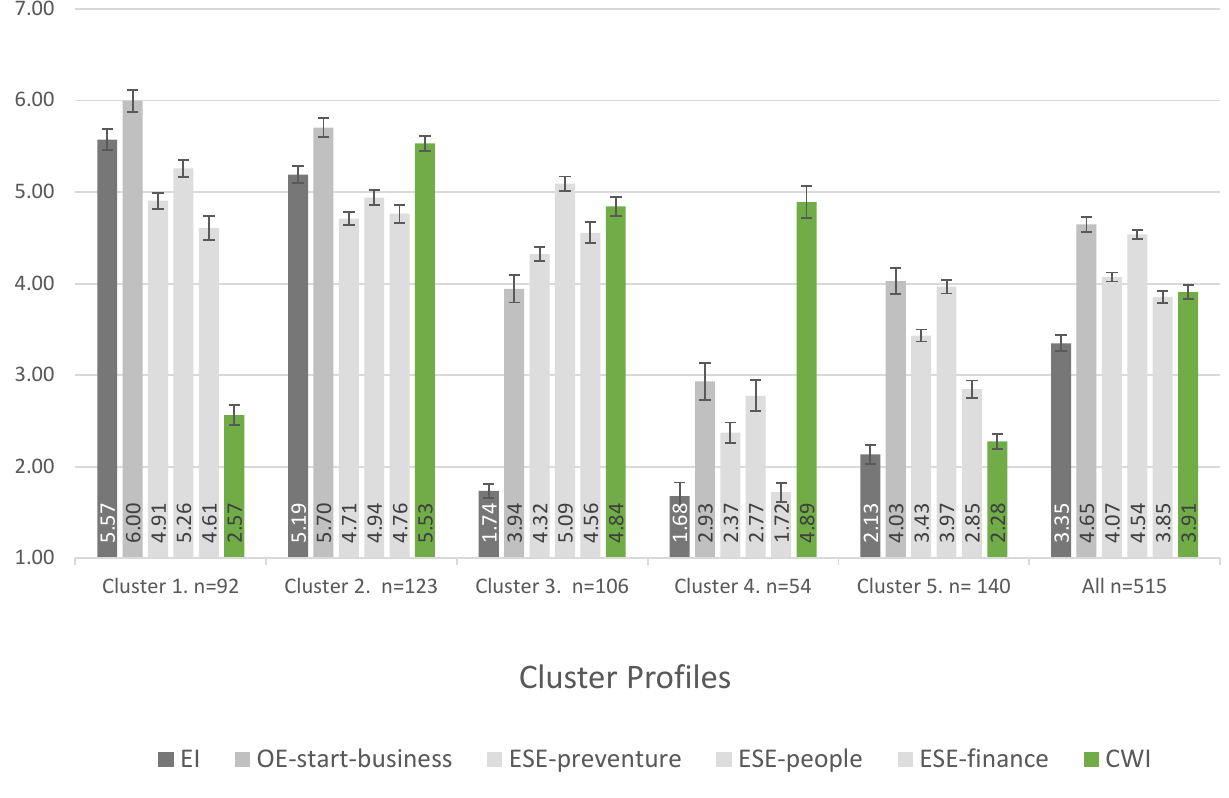
Figure 3. Attributes of cluster profiles—Mean scores (with standard errors) of entrepreneurial intention (EI), outcome expectations of starting a business (OE-start-business), entrepreneurial self-efficacy (ESE) (Pre-Venture, People and Finances dimensions), and corporate work intention (CWI) of respondents in different cluster profiles and for the whole study population (n = 515).